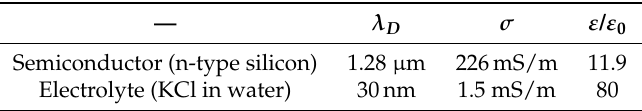
Table 2. Values for the physical properties of the liquid and the semiconductor (n-type silicon) sphere in Figure 3 ( N D = 10 13 cm − 3 ). Data obtained from